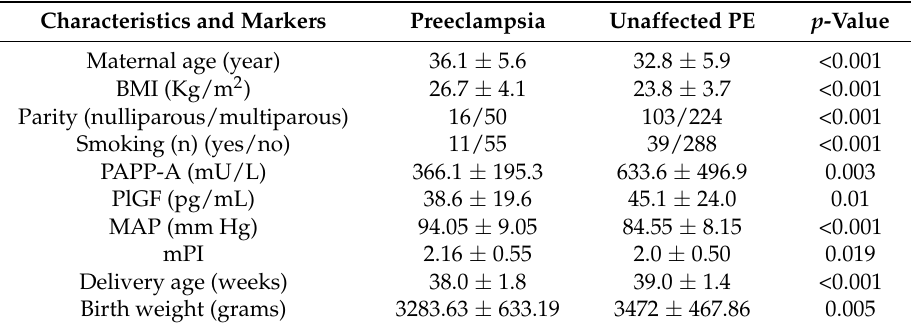
Table 3. Maternal characteristics and biomarkers in study groups.